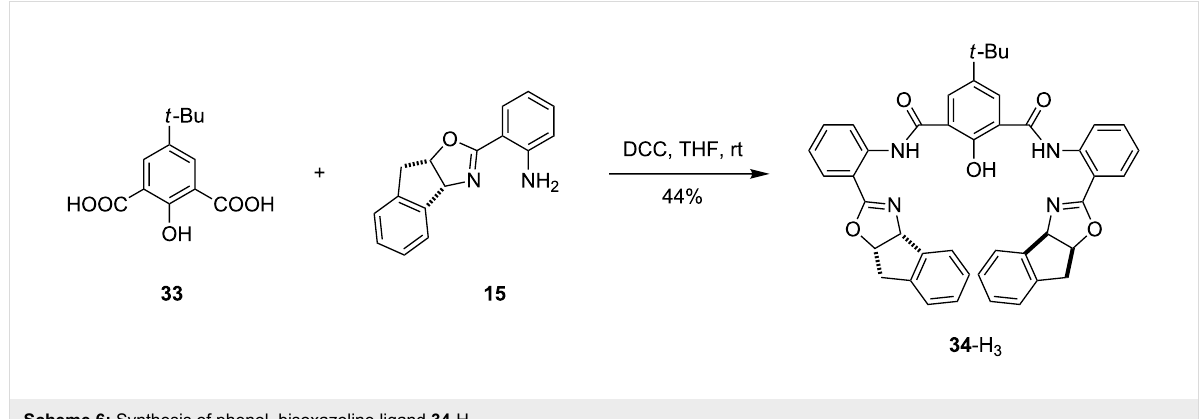
Scheme 6: Synthesis of phenol–bisoxazoline ligand 34 -H 3 .